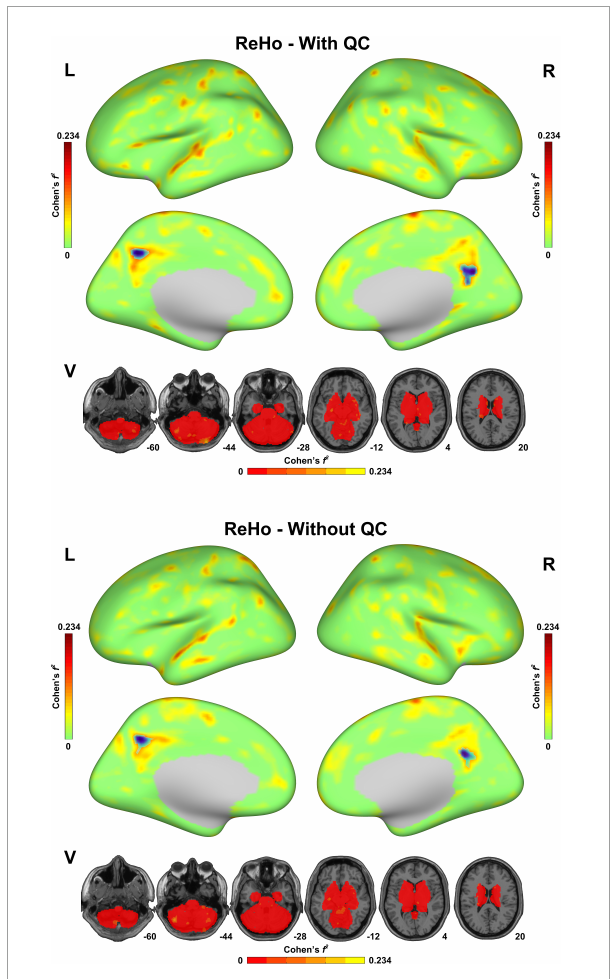
FIGURE3 Sex difference of regional homogeneity (ReHo) in the fmri-open-qc-rest dataset with/without quality control. The effect size (Cohen’s f 2 ) derived from the two-sample t -tests between males and females were displayed. The brain areas showed significantly lower ReHo in the male group than in the female group were highlighted in blue. L indicated the left hemisphere. R indicated the right hemisphere. V indicated the subcortical